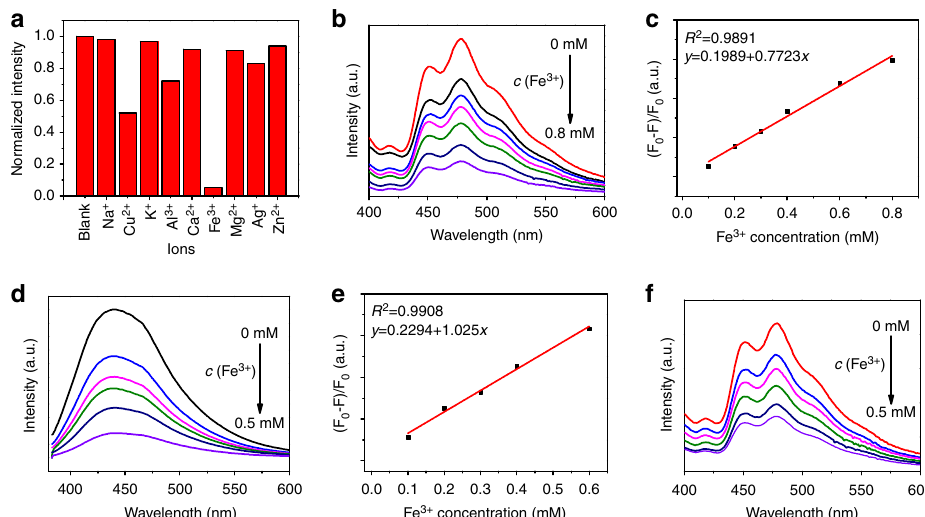
Fig. 4 Detection of Fe 3 + ions. a Normalised phosphorescence intensity of the CD-CA suspension in the presence of various metal ions. b Phosphorescence spectra of CD-CA suspensions with various calculated concentrations of Fe 3 + ; from top to bottom: 0, 0.1, 0.2, 0.3, 0.4, 0.5 and 0.8 mM. c Stern – Volmer plot as a function of Fe 3 + concentration. d Fluorescence spectra of CDs at various calculated concentrations of Fe 3 + ; from top to bottom: 0, 0.1, 0.2, 0.3, 0.4 and 0.5 mM. e Stern – Volmer plot as a function of Fe 3 + concentration. f Phosphorescence spectra of CD-CA suspensions at various calculated concentrations of Fe 3 + in a peptone solution; from top to bottom: 0, 0.1, 0.2, 0.3, 0.4 and 0.5 mM